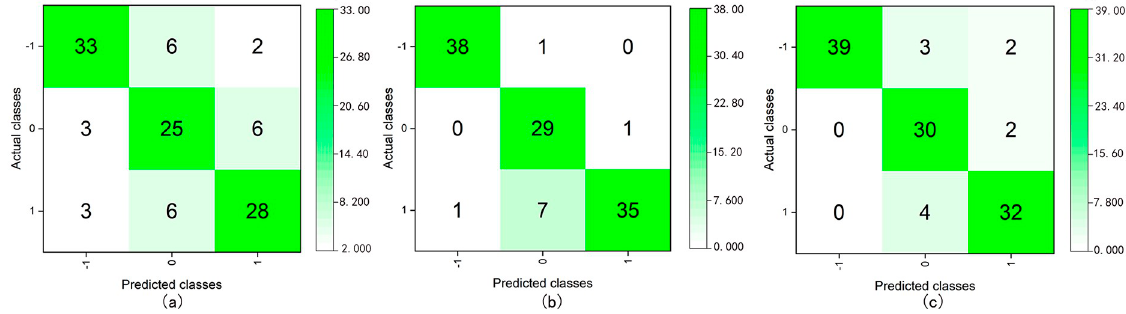
Fig 7. Confusion matrices of the ternary class classification using DT C5.0 (boosting) (a), RF (bagging) (b), and ANN (boosting) (c).